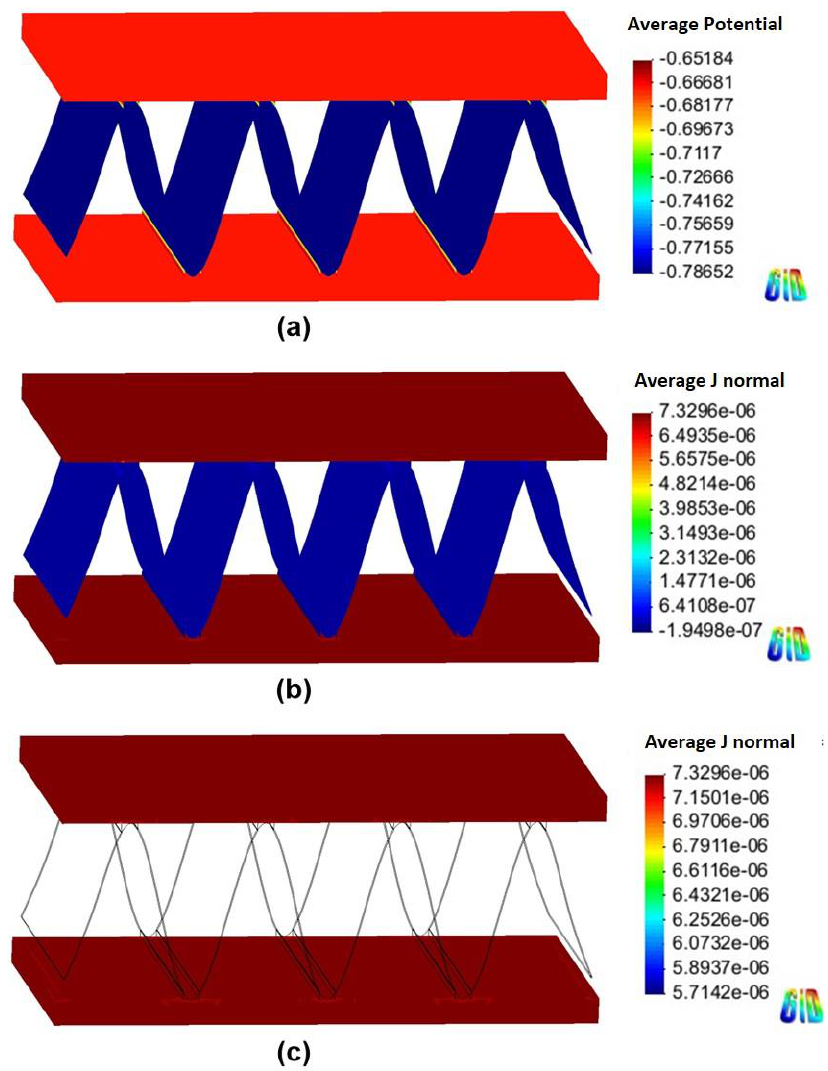
Figure 8. Simulation results of the Al fin-tube heat exchanger assembled with a cathodic joint in low-conductivity electrolyte: ( a) potential distribution, ( b ) current density distribution, and ( c ) current density distribution at the tube.